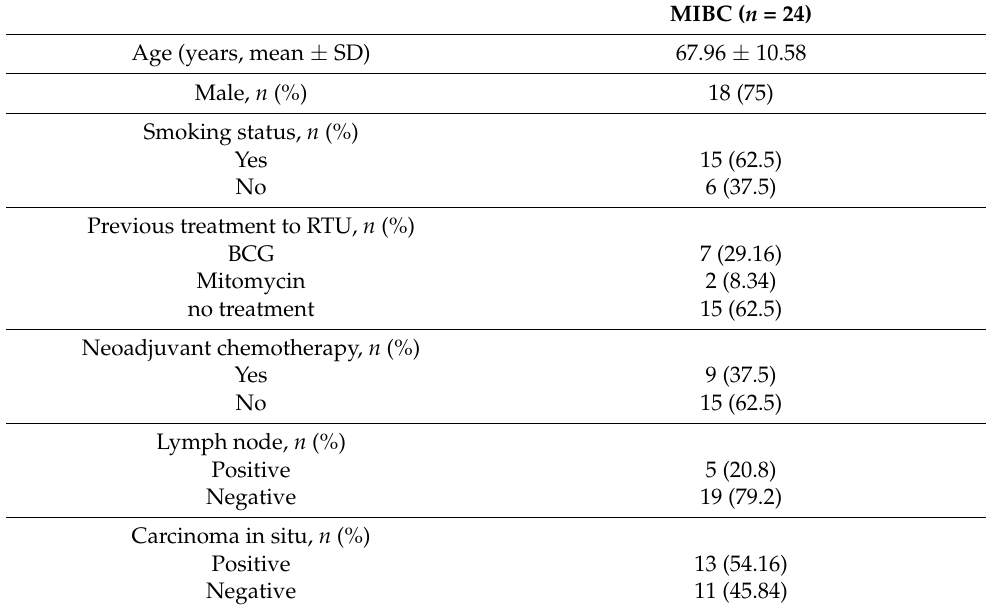
Table 1. Demographic and clinical characteristics of MIBC